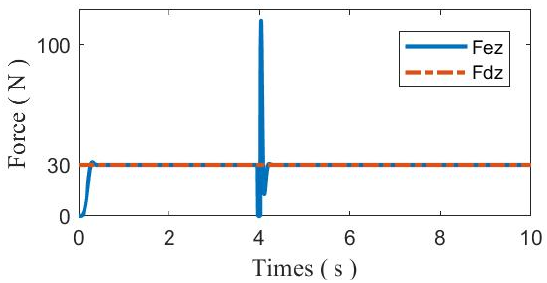
Figure 6. The contact force between shaft and hole in experiment 1.